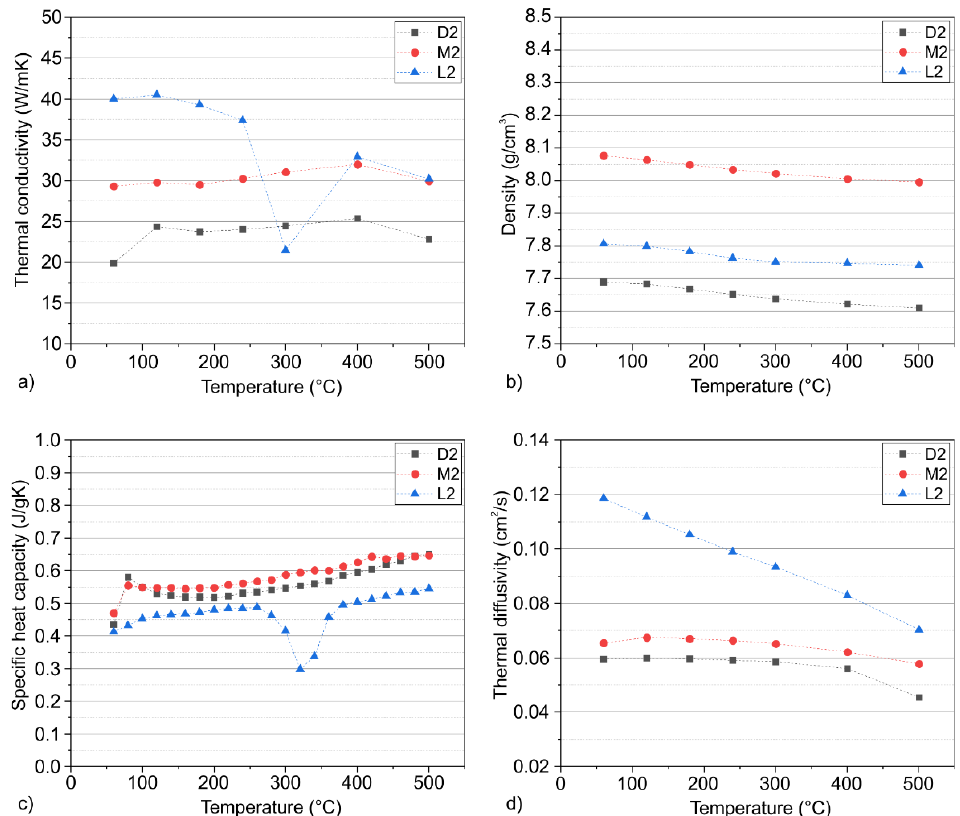
Figure 3. Thermophysical properties of the investigated alloys according to the dynamic measurement method for the calculation of the ( a ) thermal conductivity using the ( b ) density, ( c ) specific heat capacity and ( d ) thermal diffusivity.